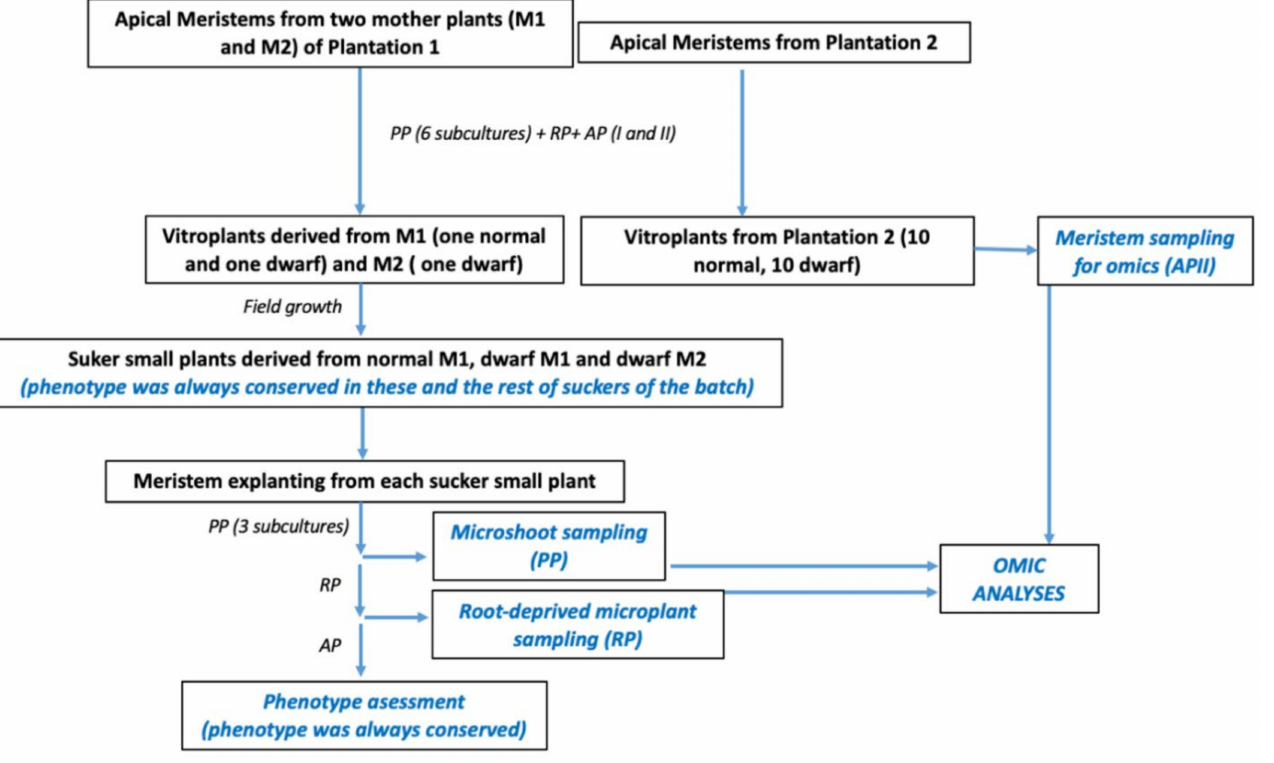
Figure 1. Plant micropropagation